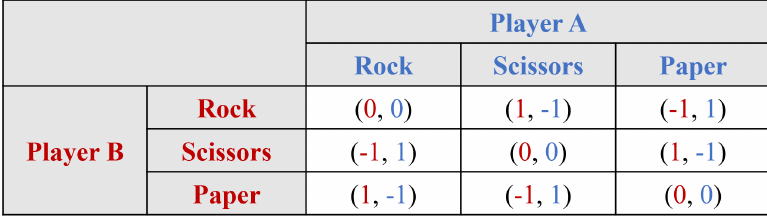
Figure 7. Example of a payoff